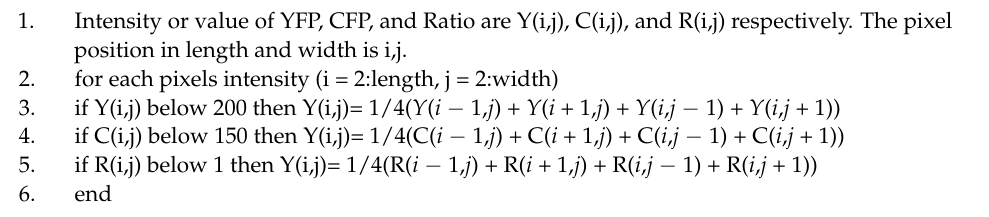
Algorithm 1 Pre-processing of RAW (DNG) images taken with a smartphone